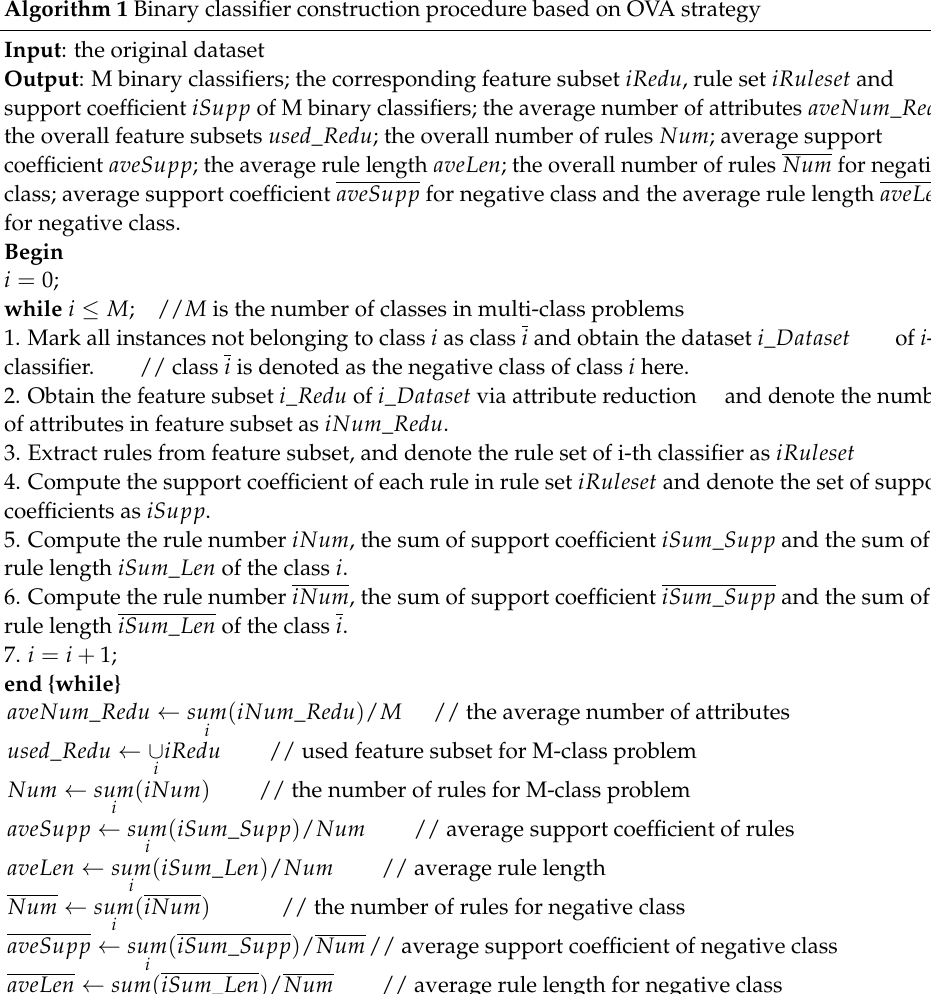
Algorithm 1 Binary classifier construction procedure based on OVA